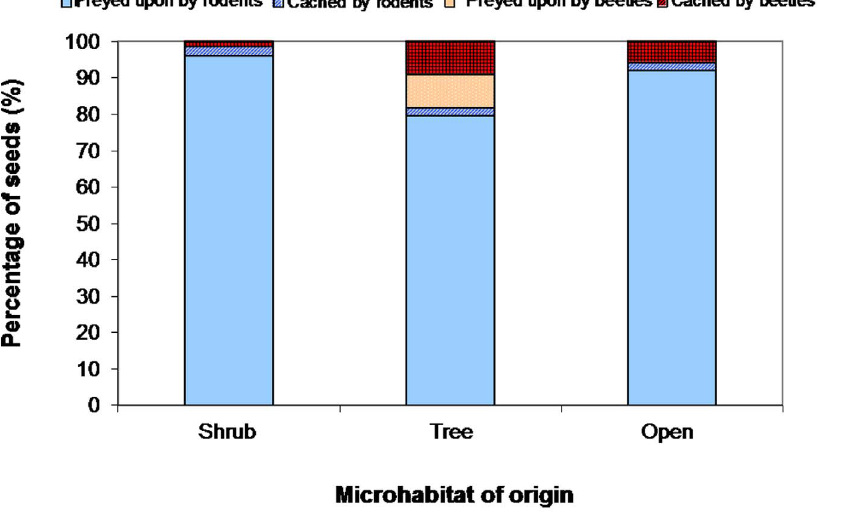
Figure 3. Seed viability after the activity of the two guilds of scatter-hoarding animals evaluated in this study. The percentage of acorns preyed upon (non-viable) or cached and undamaged (viable) by rodents and beetles is represented as a function of the microhabitat of origin (under shrubs, beneath tree canopies and open sites). Percentage values were averaged for the two sampling periods (2009/2010 and 2010/2011) and the two oak species ( Q. suber and Q. canariensis ).